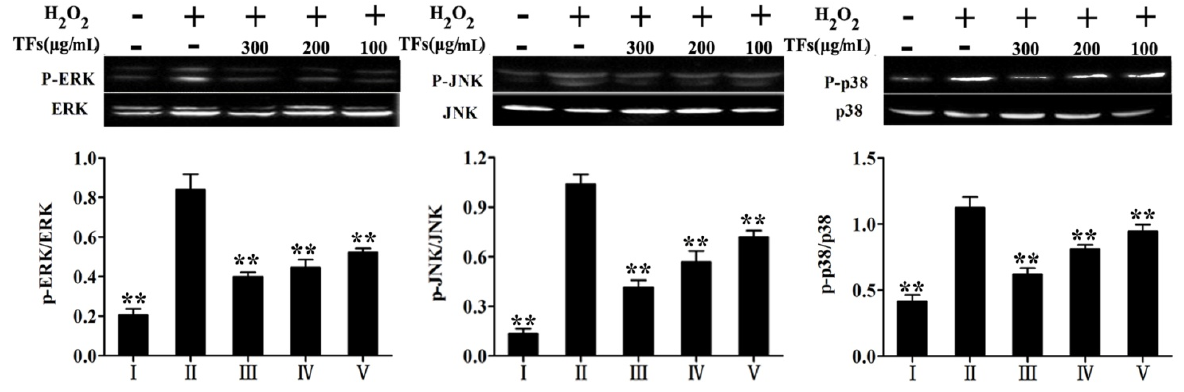
Figure 7. Effects of the TFs on the levels of MAPKs phosphorylation. Datas are presented by phosphorylation/nonphosphorylated. Values are expressed as mean ± SD ( n = 5). * p < 0.05 and ** p < 0.01 compared with model